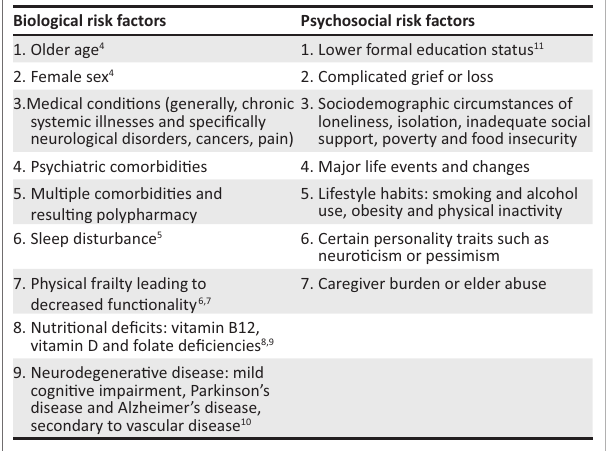
FIGURE 1: Risk factors for the development of late-life